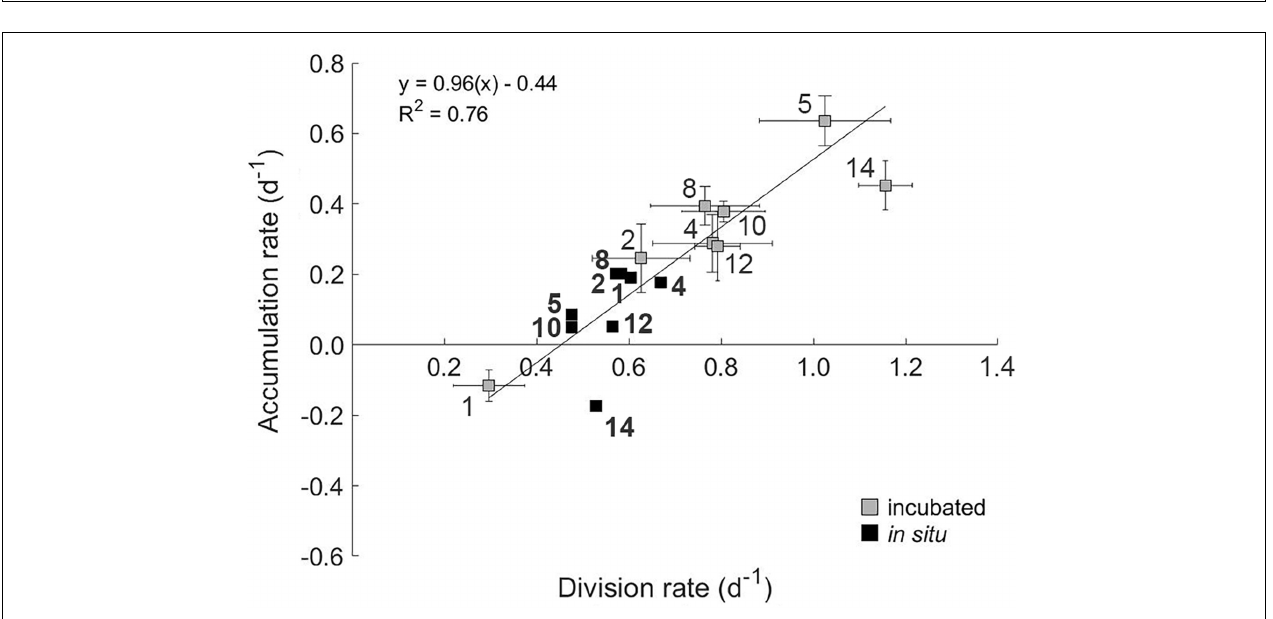
FIGURE 5 | The average gross division rate of phytoplankton groups versus the light level during experimental incubations. The solid line is a fit of the photosynthesis-irradiance (P-I) model of Platt et al. (1980) to our division rate versus PAR data. Station numbers are indicated on plot. Error bars represent standard error.